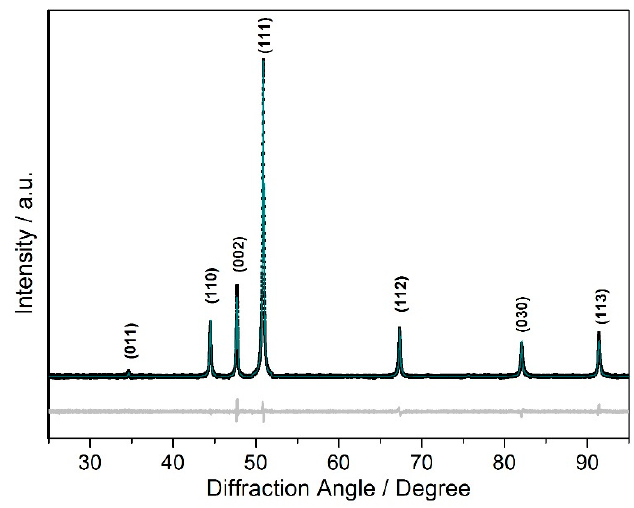
Figure 2. Powder X-ray di ff raction pattern (Co K α 1 radiation) of ε -Fe 2 MnN. Black symbols represent measured intensities, the dark cyan line represents calculated intensities, and the light gray line below the diagram shows the di ff erence. Intensities are given on a linear scale. Table 1. Data collection 1 , structure refinement and crystallographic information for Fe 2 MnN. A second sample with a 5% excess of nitrogen according to chemical analysis resulted in lattice parameters a = 4.7344(4) Å and c = 4.4264(5) Å.